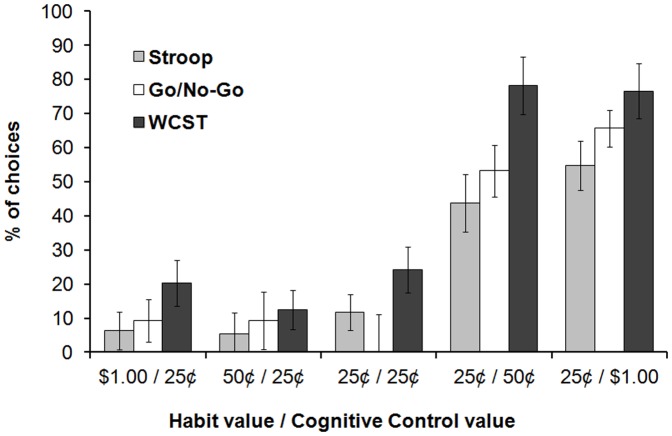
Behavioral Results.Percentage (%) of choices in which cognitive control was selected during the free-choice period as a function of expected monetary rewards. Error bars represent one (within-subject) standard error of the mean based on Loftus and Masson [69].